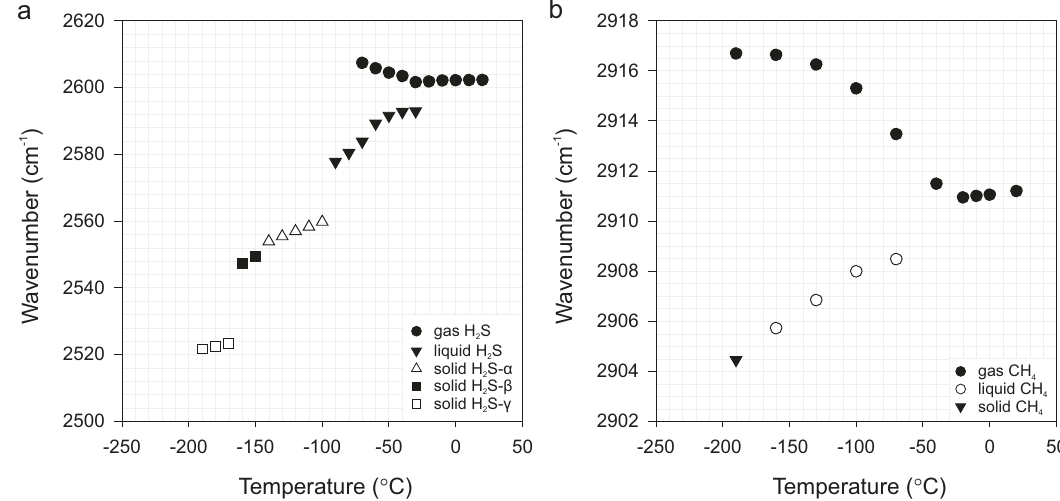
Fig. 9 Diagrams showing the relationship between temperature and Raman band wavenumbers. a Shifts in peak positions of H 2 S vapor, liquid, and solid ( α , β , γ ) phases with decreasing temperature. The measurements were recorded in 10 °C increments. b Shifts in band positions of vapor, liquid and solid CH 4 with decreasing temperature. The measurements were recorded in 30 °C increments. Both H 2 S and CH 4 show similar trends, namely Raman peak positions of volatile phases shift towards higher wavenumbers, whereas less volatile components reveal opposite tendency. This discrepancy re fl ects differential partitioning between co-existing phases. The data were collected from one individual fl uid inclusion (no. P1a- fi 10) during the heating run. The peak positions were calibrated using neon emission lines. See also Source Data fi